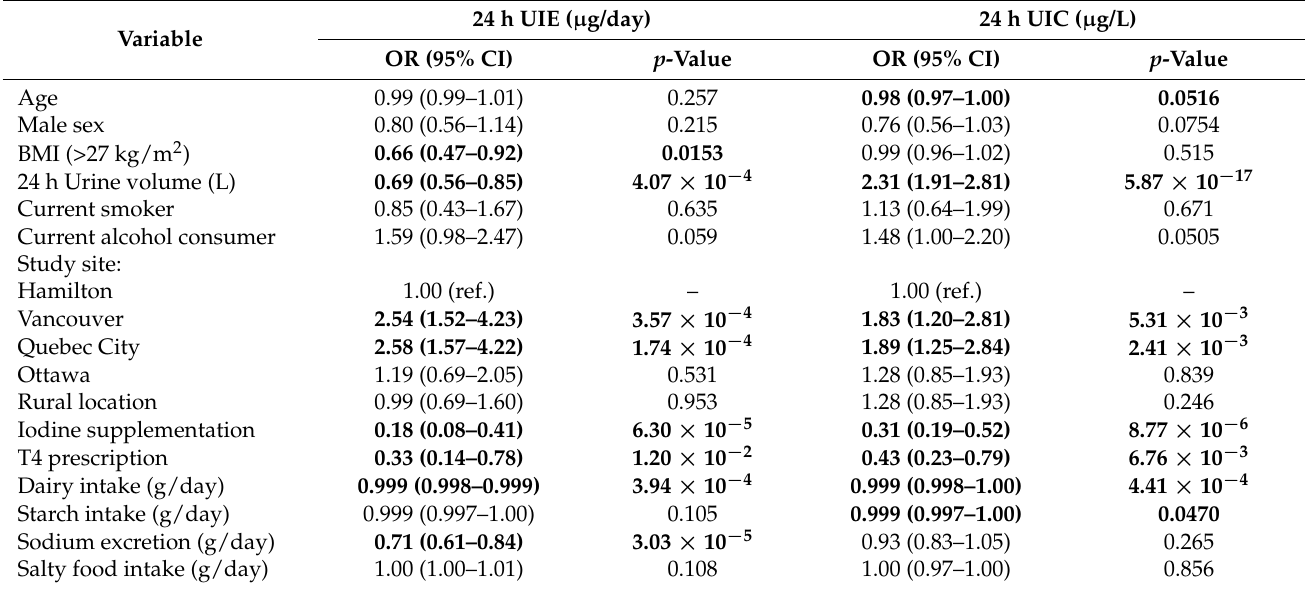
Table 1. Protective and risk factors for iodine deficiency (<150 µ g/day or <100 µ g/L) among PURE- 24USE participants ( n = 800) using a binary linear logistic regression. Significant variables ( p < 0.05) are bolded after adjustments for age, sex, BMI, total caloric intake and AHEI